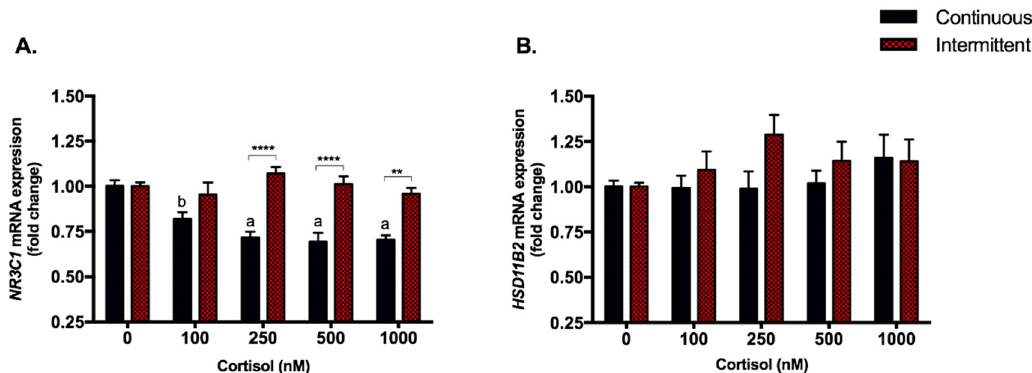
Figure 2. Glucocorticoid receptor and HSD11B2 enzyme gene expression. RT-qPCR of NR3C1 ( A ) and HSD11B2 ( B ) in SGHPL-4 cells treated with continuous or intermittent exposure to cortisol (100, 250, 500, 1000 nM) and vehicle (0 nM) in the medium. Data were compared by two-way ANOVA with Tukey multiple comparisons test. Interaction between (continuous or intermittent) exposure to cortisol and cortisol dose was found for NR3C1 ( p < 0.0001). Data are presented as mean ± SEM. ** p < 0.01; **** p < 0.0001; for continuous exposure: b, p < 0.05 and a, p < 0.0001 vs. control. NR3C1 , Glucocorticoid receptor; HSD11B2 , 11-hydroxysteroid dehydrogenase type 2. Cell treatment was repeated at least three